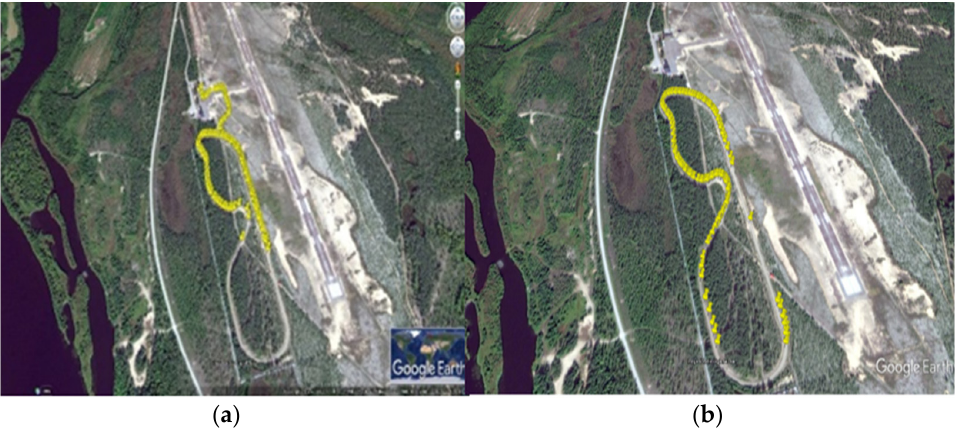
Figure 7. ( a ) RWS-1 packet capture using ITS-G5 ( b ) RWS-2 packet capture using ITS-G5.